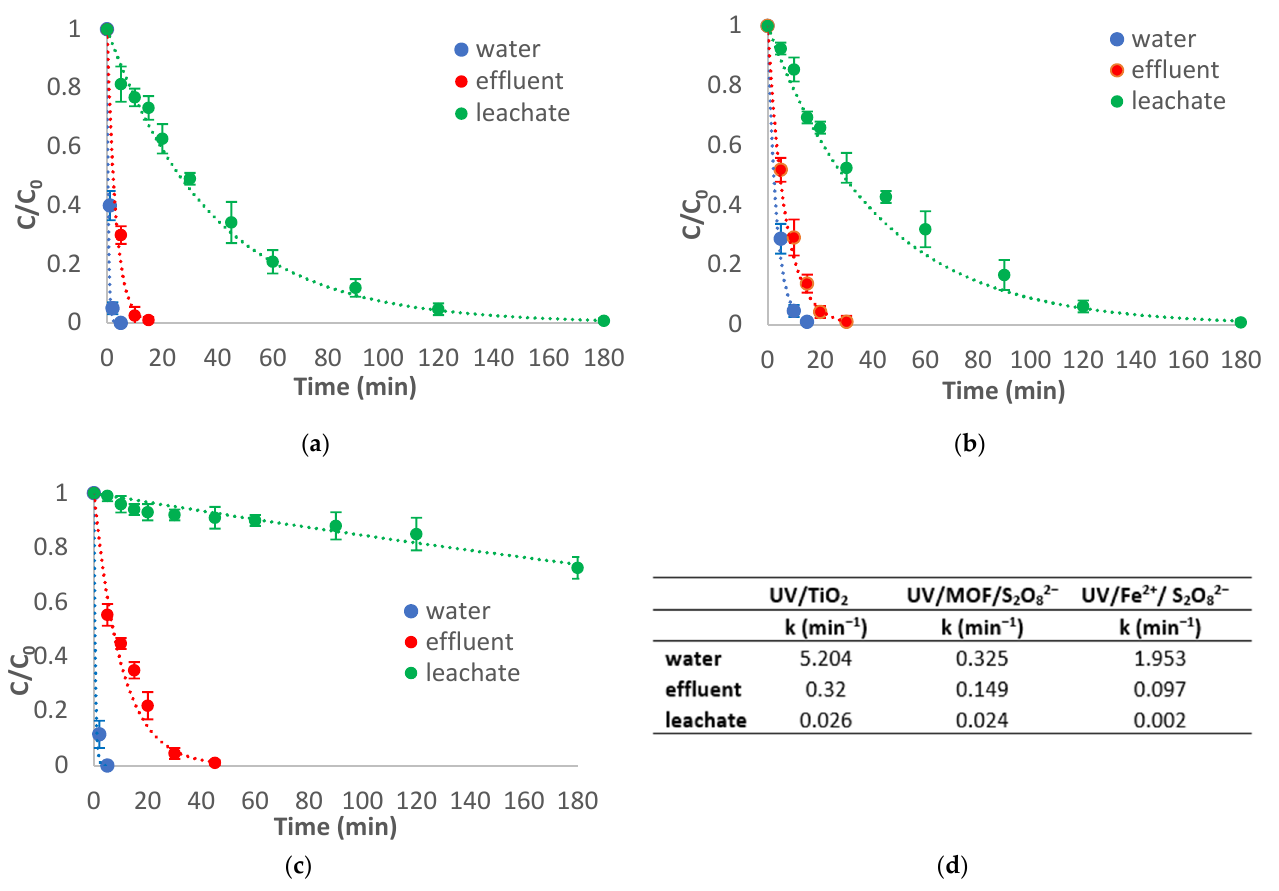
Figure 6. Photocatalytic degradation of abacavir in different matrices using ( a ) UV/TiO 2 photocatalysis, ( b ) UV/MOF/S 2 O 82 − ( c ) UV/Fe 2+ /S 2 O 82 − , and ( d ) calculated k values for all applied AOPs in different matrices. C 0 = 10 mg/L, C catalyst = 100 mg/L, CFe 2+ = 1 mg/L, C oxidant = 15 mg/L.